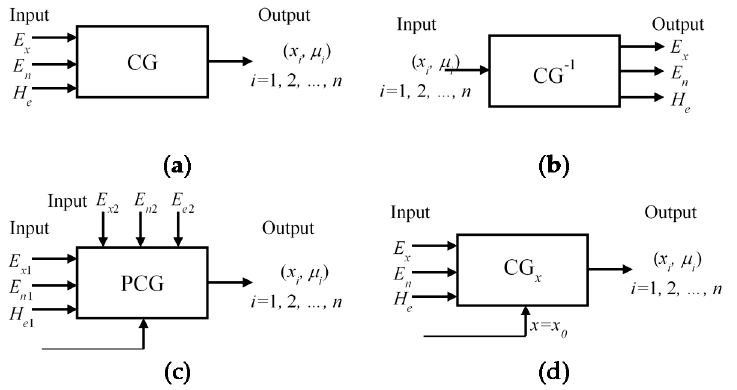
Figure 1. Graphic expression of different cloud generators. ( a ) The forward cloud generator; ( b ) the backward cloud generator; ( c ) the two-dimensional cloud generator; ( d ) the x-condition cloud gen-